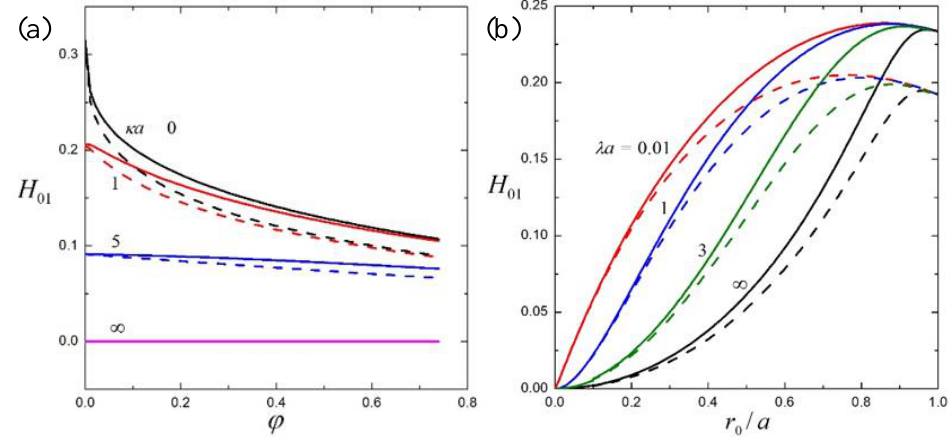
Figure 5. The electrophoretic mobility coe ffi cient H 01 for a suspension of soft spheres: ( a ) λ a = 1 and r 0 / a = 0.5; ( b ) κ a = 1 and ϕ = 0.1. The solid and dashed curves represent the calculations for the Happel and Kuwabara models, respectively.